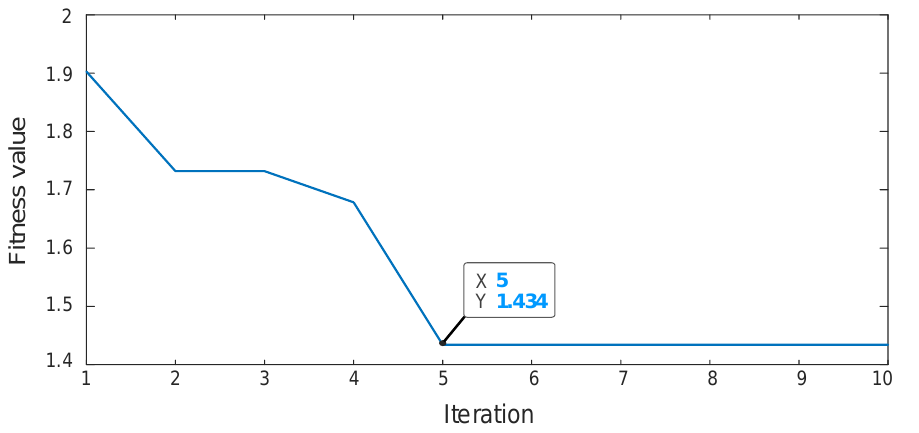
Figure 12. The RSSD optimized convergence curve of comparative method. The envelope spectrum analysis shown in Figure 11b, the fault characteristic frequency f r 1 and its multiples 4 f r 1 do not prominent in the envelope spectrum. The fault feature fre- quencies dominate in the frequency spectrum with the optimized resonance decomposition from Figure 11d. The fault characteristics of the HSS pinion are accurately identified. The same procedure is applied for the IMS gear, and the parameters obtained with the optimized RSSD are: Q H = 8.2, Q L = 2.9, r H = 5, and r L = 3.5. Some of the disturbances are removed in the time domain as shown in Figure 13. However, it failed to extract the fault feature frequency of the IMS gear effectively due to the performance of MCKD.